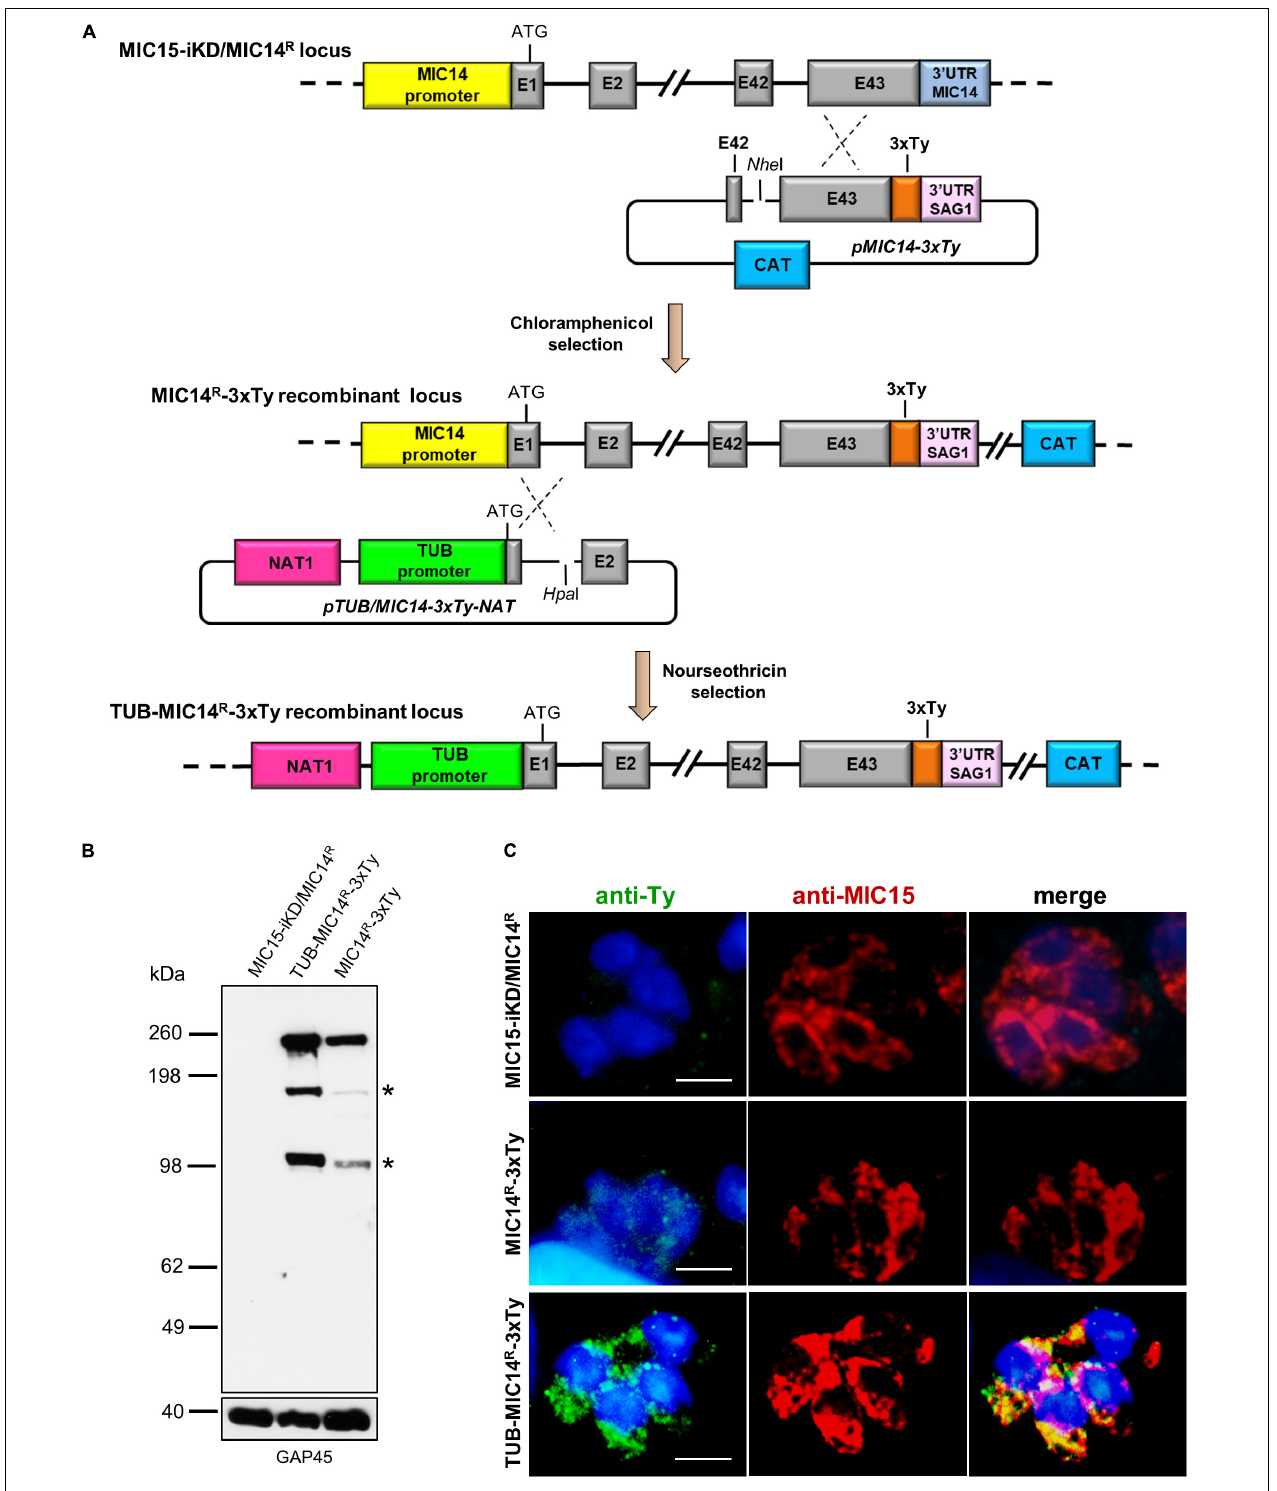
FIGURE 8 | Generation and characterization of parasite lines expressing C-terminally tagged MIC14. (A) The upper part of the diagram shows the single homologous recombination strategy for integration of the 3x-Ty epitope sequence (in orange) at the 3 (cid:48) end of the MIC14 coding sequence in MIC15-iKD/MIC14 R parasites. In the obtained chloramphenicol-resistant strain MIC15-iKD/MIC14 R -3xTy, the MIC14 locus was further modified by single homologous recombination (lower part of the diagram) by replacing the endogenous promoter of MIC14 with the T. gondii β -tubulin constitutive promoter, obtaining the